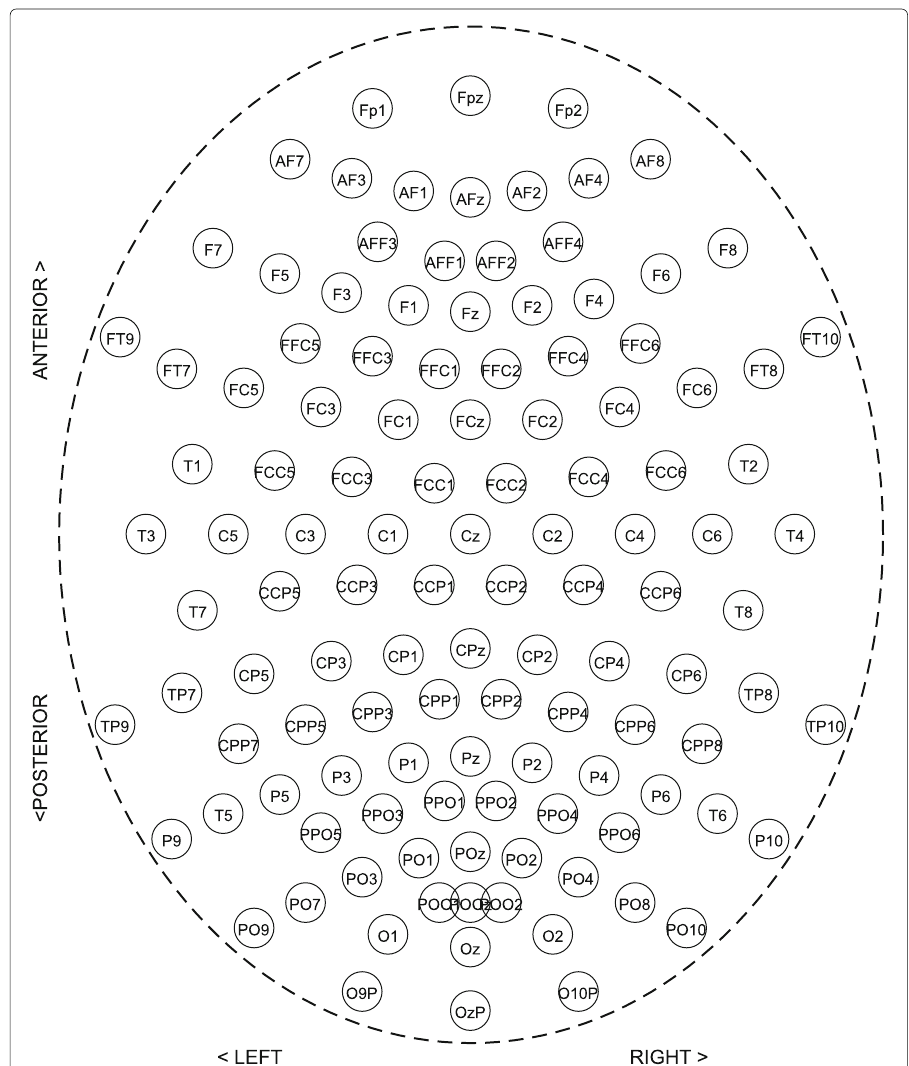
Fig. 2 Electrode positions and labels in the 10-20 system Oostenveld and Praamstra (2001). Black circles indicate positions of the original 10-20 system, gray circles indicate additional positions introduced in the 10-10 extension. Each site has a letter to identify the general brain region and a number to identify the hemisphere location. The letters, Fp, F, T, C, P, and O stand for fronto-polar, frontal, temporal, central, parietal, and occipital, respectively. For further explanation of the 10-20 system, see Oostenveld and Praamstra (2001)